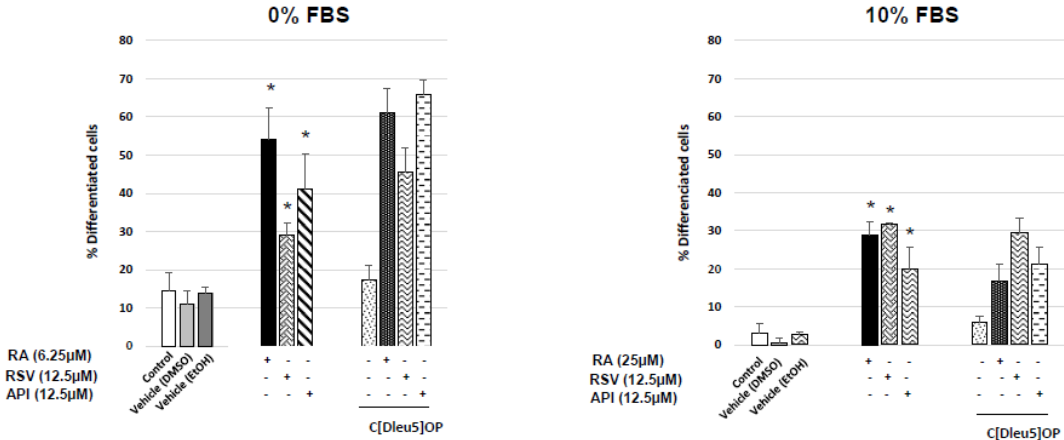
Figure 6. Evaluation of the implication of the ODN receptor in neuronal differentiation induced by resveratrol and apigenin on N2a cells. Murine neuronal N2a cells previously cultured for 24 h in conventional cultured medium were further cultured for 48 h in medium without or with 10% FBS in the absence or in the presence of retinoic acid (RA: 6.25 µ M with 0% FBS; 25 µ M with 10% FBS) used as positive control for the induction of neuronal differentiation, or with polyphenols: resveratrol (RSV: 12.5 µ M with 0% and 10% FBS) and apigenin (API: 12.5 µ M with 0% and 10% FBS). RSV and API